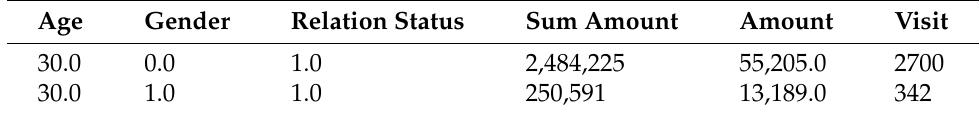
Table 5. Need based Package for Category A.